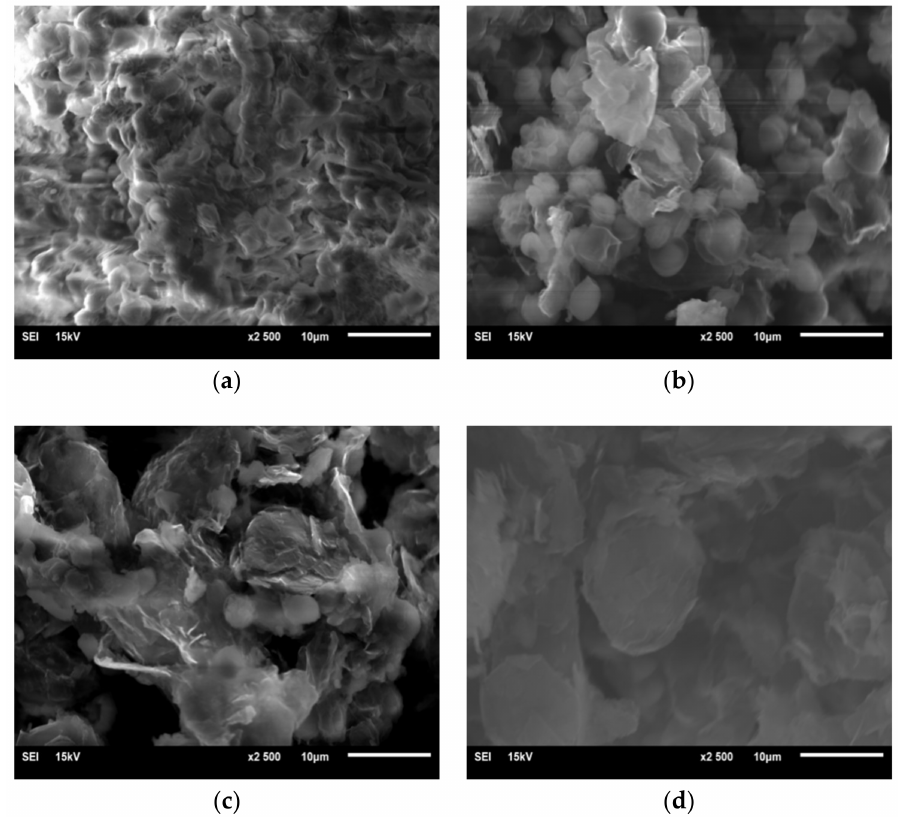
Figure 9. ( a ) SEM image of Chlorella in normal state; ( b ) SEM image of Chlorella in reactor T3 with graphene concentration of 1 mg/L; ( c ) SEM image of Chlorella in reactor T5 with graphene concentration of 4 mg/L; ( d ) SEM image of Chlorella in reactor T6 with graphene concentration 8